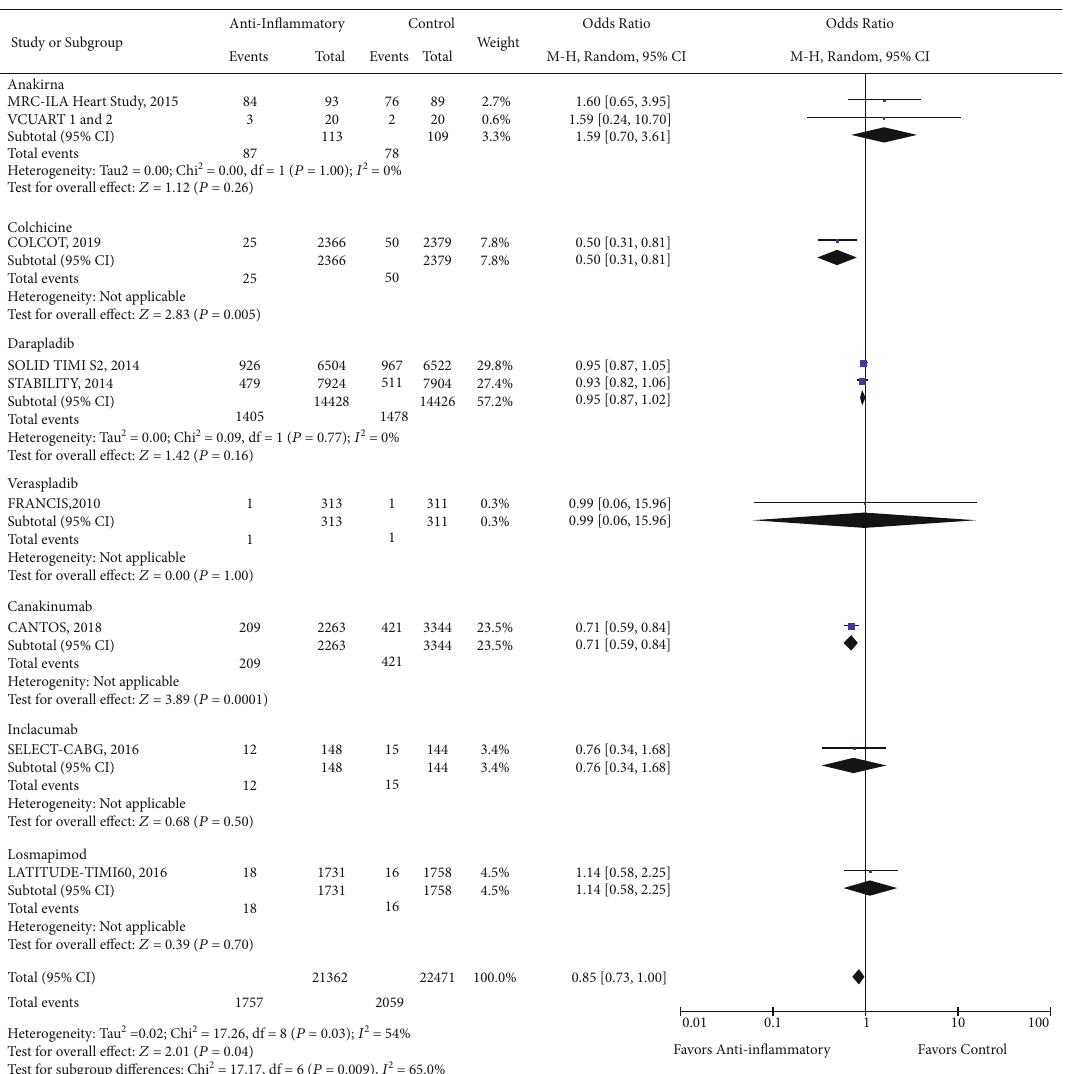
Figure 2: Forest plot for the comparative risk of revascularization with anti-in fl ammatory therapy versus standard of care alone. Anti- in fl ammatory therapy signi fi cantly reduced the risk of revascularization (OR 0.85, CI 0.73-1.00; P < 0 : 05